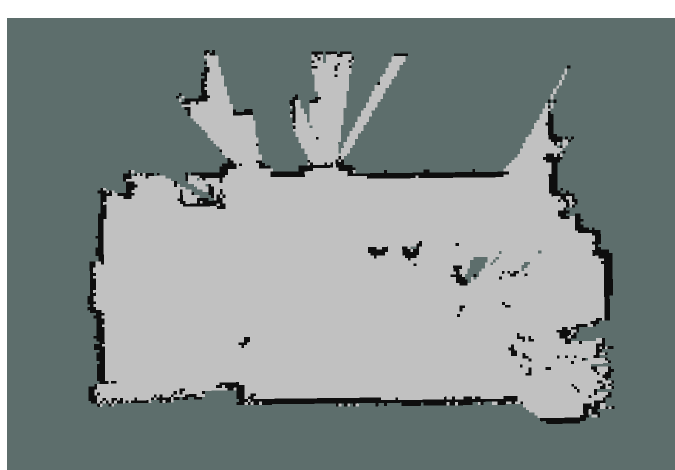
Figure 6. Two-dimensional Occupancy Grid using Gmapping.